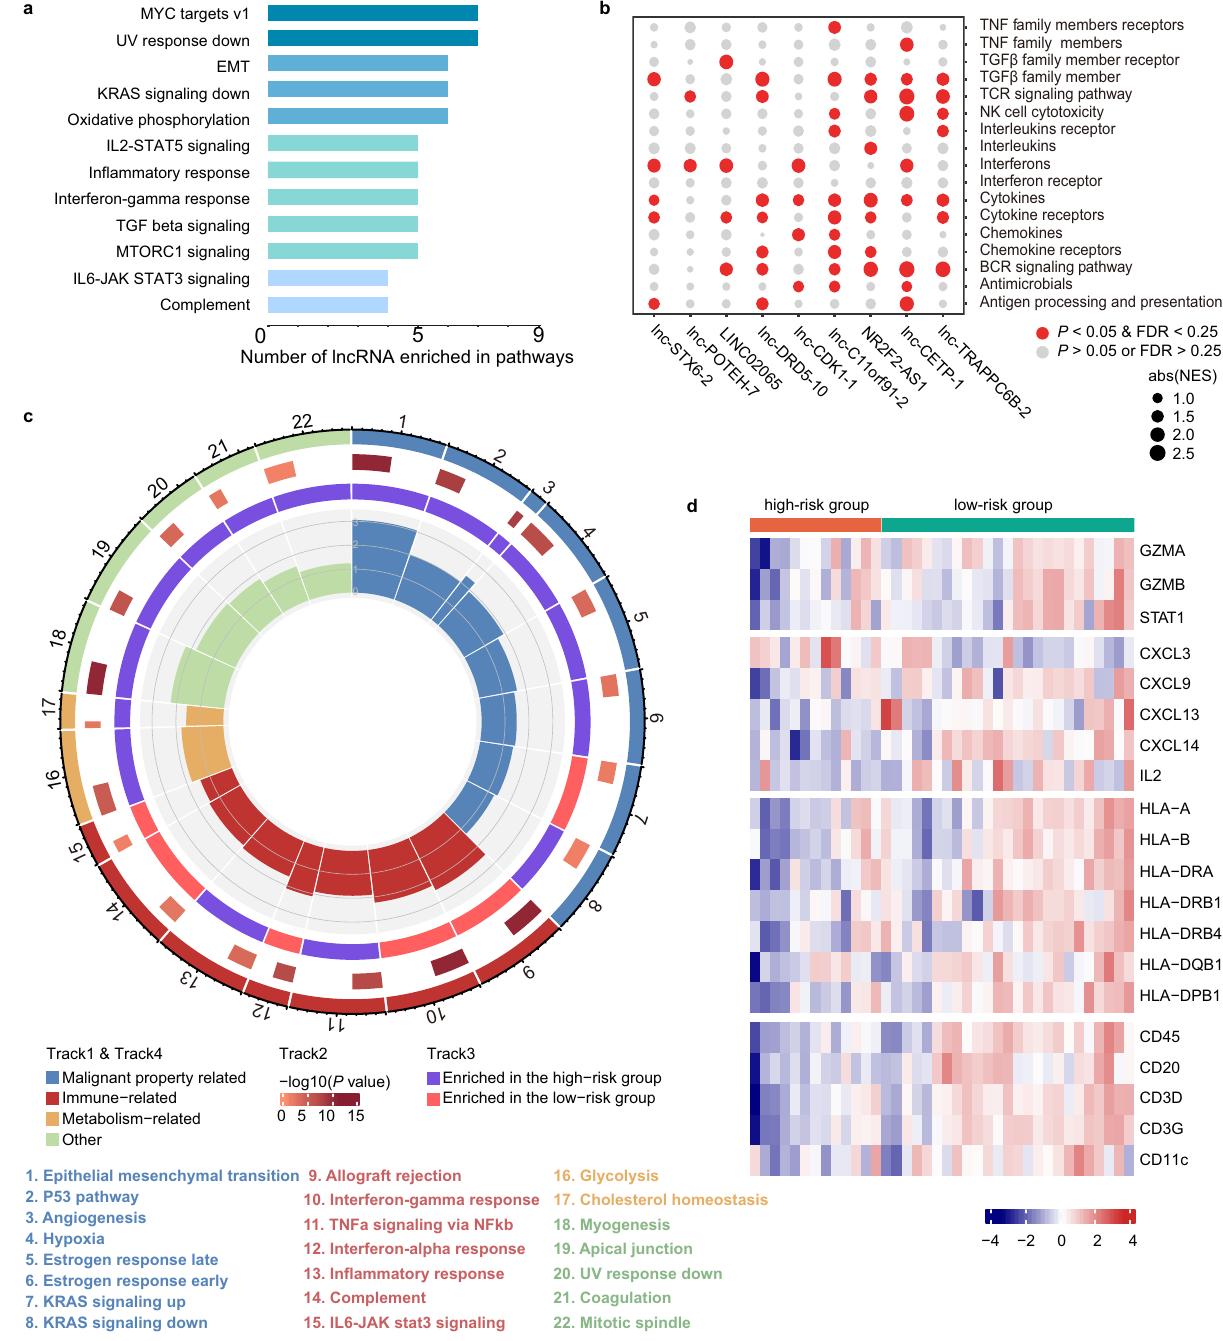
Fig. 5 Molecular characteristics of high-risk and low-risk groups. a Bar plot showing the number of lncRNAs out of the nine lncRNAs in the signature that are enriched in that corresponding pathway by functional enrichment analyses based on GSEA. Permutation-based P value shows the statistical signi fi cance of the normalized enrichment score (NES). Adjustments for multiple comparisons were presented by false discovery rate (FDR). Signi fi cantly enriched pathways are de fi ned as P < 0.05, FDR < 0.25, and absolute NES > 1. b Bubble plot of GSEA results of the nine lncRNAs with immunologically relevant pathways in LA-NPC patients of the discovery cohort ( n = 38). The red color of the dots represents enrichment ( P < 0.05, FDR < 0.25, absolute NES > 1), and the size of the dots represents absolute NES. Permutation-based P value shows the statistical signi fi cance of NES and adjustments for multiple comparisons were presented by FDR. c Circos plot showing the signi fi cantly enriched pathways between the high- and low-risk groups based on GSEA. The size of each sector represents the number of genes in the labeled pathway. The color of the outmost circle and inner bar plots represent the category of pathways. The size of the second outer circle represents the percentage of genes contributing to the enrichment score, and its color represents the magnitude of the statistical signi fi cance (shown as − log10 ( P value)). The color of the third circle indicates that the labeled pathway is upregulated in the high- or low-risk group. The size of the inner bar plot shows the absolute NES. Permutation-based P value shows the statistical signi fi cance of NES and adjustments for multiple comparisons were presented by FDR. d Heatmap of differentially expressed immune-related genes between the high- and low-risk groups (Student ’ s two-sided t -test, P value < 0.05). FDR false discovery rate, NES normalized enrichment score. Source data are provided as a Source Data fi